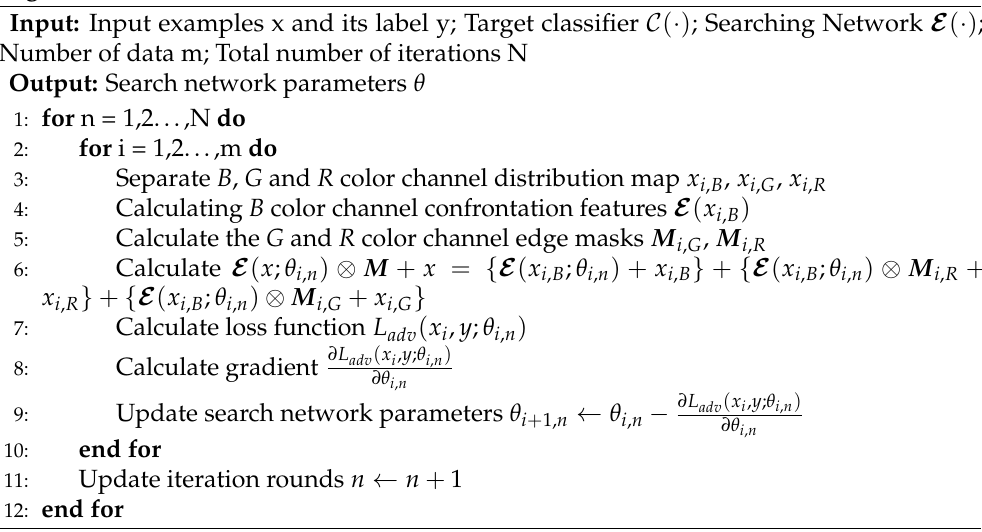
Algorithm 1 ADSAttack adversarial